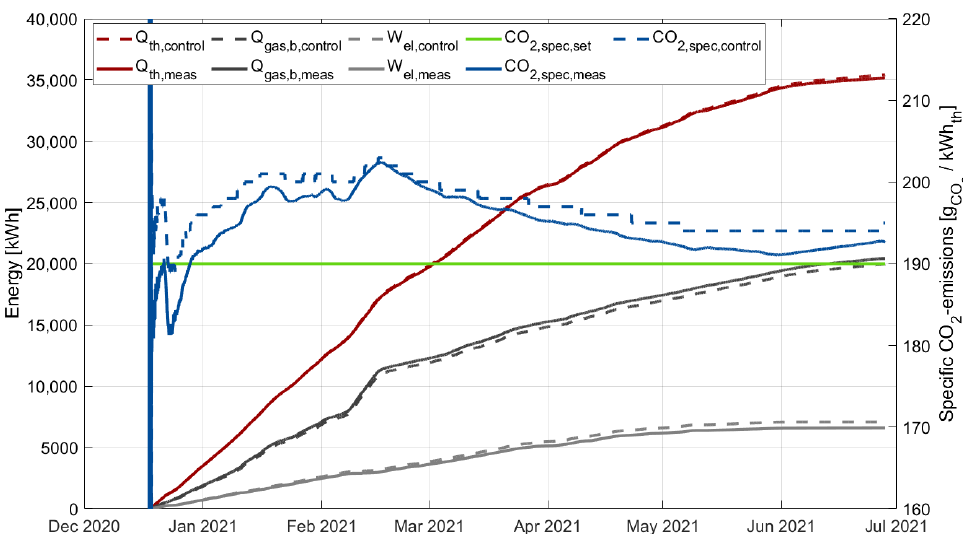
Figure 14. Comparison of measured and internally calculated provided heat and used final energy of both heat generators and respective specific CO 2 emission with corresponding set point.